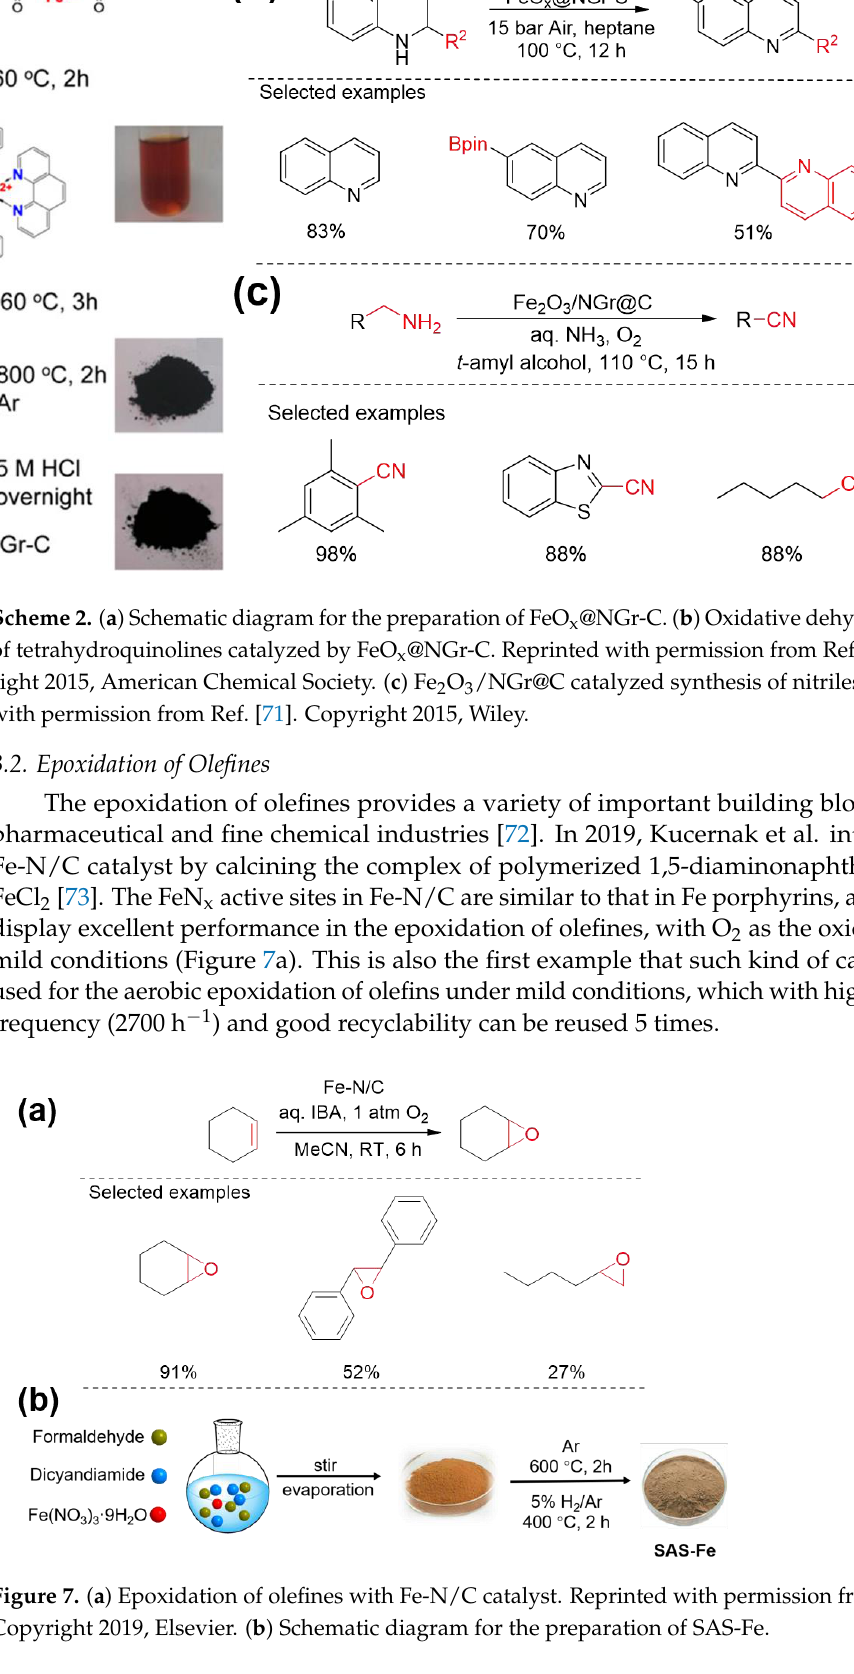
Figure 8. DFT calculations of styrene epoxidation over SAS-Fe (* represents the active sites). Re- printed with permission from Ref. [74]. Copyright 2020, Wiley. 3.3. Selective Oxidation of Hydrocarbons In 2015, Deng et al. fabricated highly dispersed single FeN 4 centers by high-energy ball milling of the mixture of iron phthalocyanine (FePc) and graphene nanosheets (GNs) under controlled conditions. The obtained catalyst FeN 4 /GN exhibits excellent activity for oxidizing benzene to form phenol at room temperature using H 2 O 2 as oxidant [48]. The catalytic mechanism of FeN 4 /GN is proposed based on the results of control experiments and DFT calculations, indicating that the formation of Fe=O moiety is a critical step to realize the transformation of benzene to phenol (Figure 9a). Nanocarbon-supported iron catalysts were found to show “platinum-like” proper- ties in catalytic reactions, while the specific active site on them still remains controversial. Along this line, Zhang et al. synthesized an atomically dispersed Fe-N-C catalyst for the